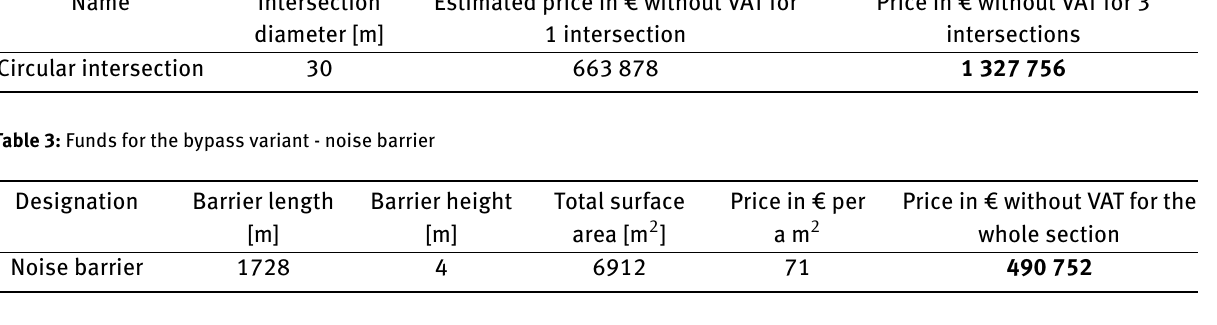
Table 4: Funds for the bypass variant - asphalt bypass surface Length of the communication